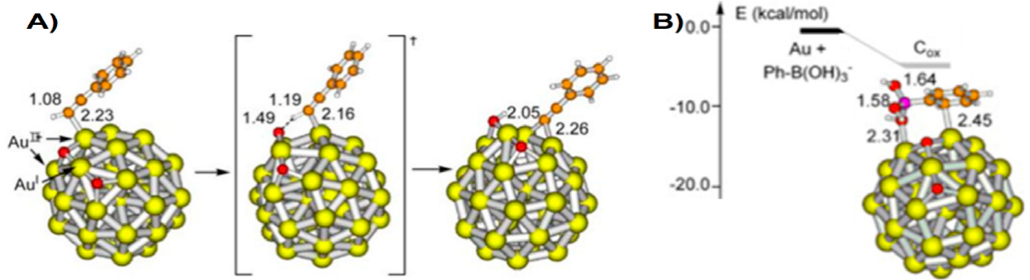
Figure 2. Calculated energy of the dissociation of PhB(OH) 3 − anion ( A ) and deprotonation of PA ( B ) on the Au 38 O 2 cluster. Reproduced with permission from [30]. American Chemical Society, 2012.